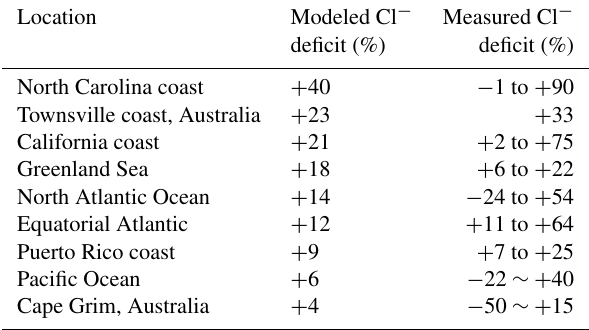
Table 3. Chloride deficits in sea salt aerosol a .